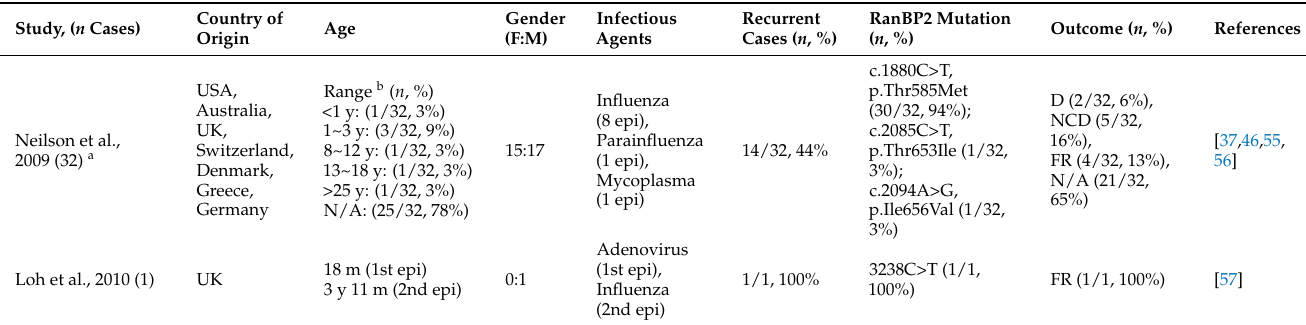
Table 1. Clinical information of ANE1 in 96